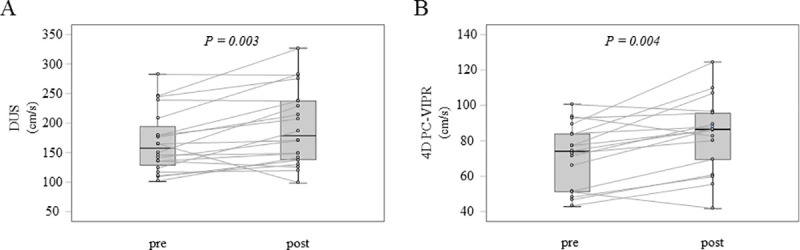
Peak velocity and peak cross-sectionally averaged velocity of SMA.(A) Comparison by actual measurement before and after oral administration in DUS (p = 0.003, Wilcoxon signed-rank test). (B) Comparison of measured values before and after oral administration in 4D PC-VIPR (p = 0.004, Wilcoxon signed-rank test).